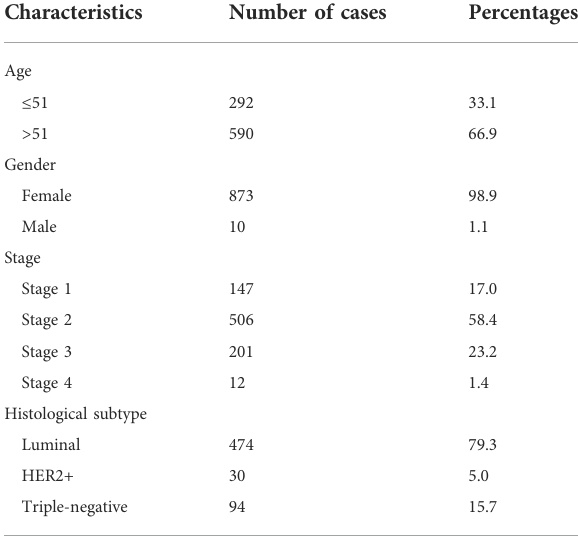
TABLE 1 Patient characteristics of breast cancer based on